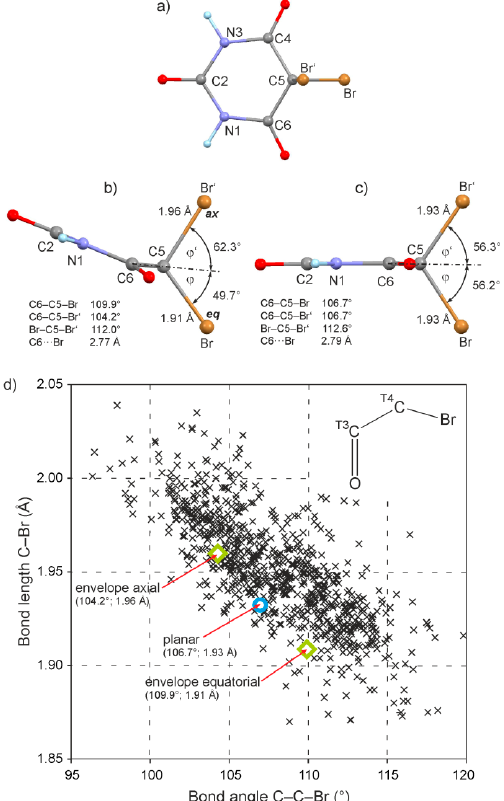
Figure 7. ( a ) Numbering scheme for 1 (gray = C, light blue = H, blue = N, red = O, brown = Br). ( b ) PBE0/aug-cc-pVTz optimized molecular structure of 1 showing a C5-endo envelope conformation of the pyrimidine ring [view parallel to the plane defined by (N1, C2, N3, C4, C6), with N3 and C4 superimposed by N1 and C6, respectively; the trace of the plane defined by (C4, C5, C6) is drawn as a dash-dot line; ϕ and ϕ ′ are defined as the angles formed between this plane and the equatorial C5–Br O=C(sp 2 )–C(sp 3 )–Br fragments (inset in upper right-hand corner; from 541 crystal structures with plotted against the corresponding C–C–Br bond angle. The bond parameters of the molecular structures shown in ( b ) and ( c ) are represented by the green rhombuses and the blue circle, respectively.